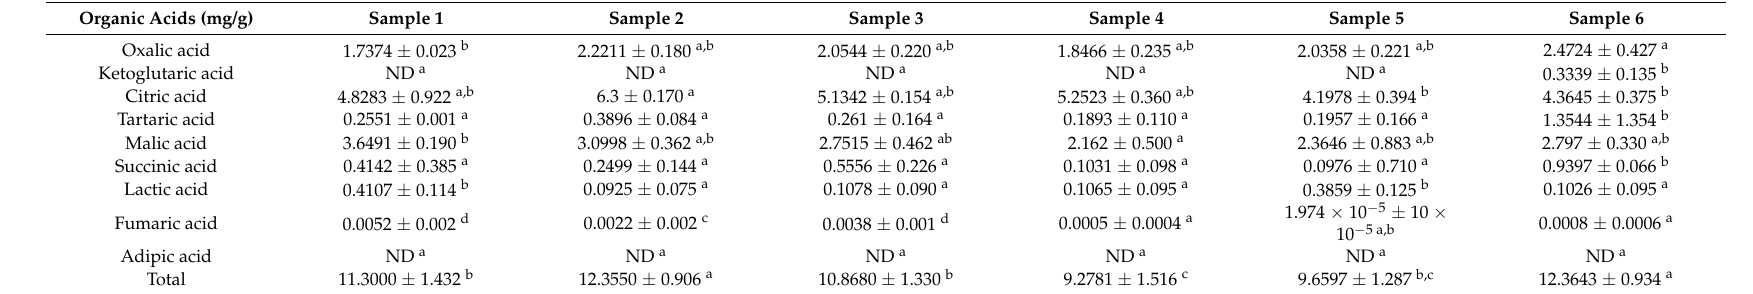
Table 2. Analysis of organic acid contents of Pixian broad-bean paste samples ( n =